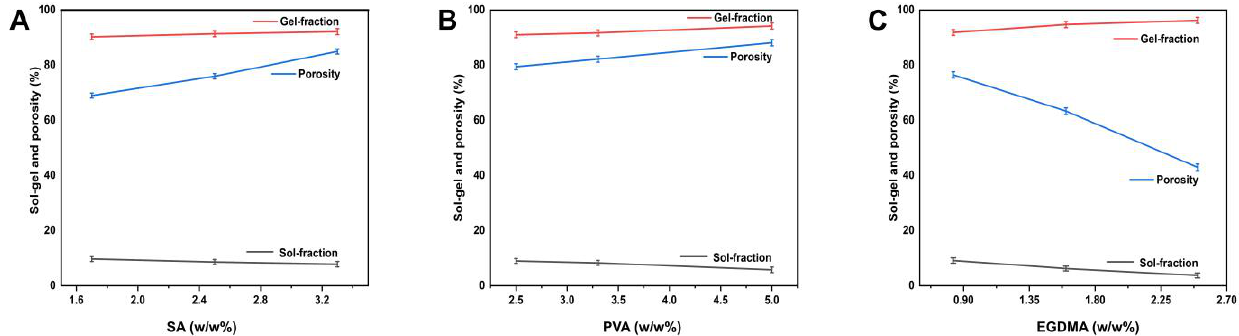
Figure 3. Mechanical properties of hydrogel membranes, such as tensile strength ( A ) and elongation at break ( B ). (Here, * represent p value < 0.05, ** p < 0.01, and *** p < 0.001).